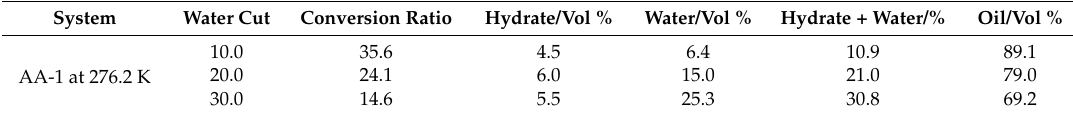
Table 3. Conversion ratios of water and volume fractions of different phases for equilibrium viscosities of hydrate slurries for AA-1 (formed at 276.2 K), AA-2 (formed at 276.2 K and at 278.2 K) and AA-3 (formed at 278.2 K) systems with an initial pressure of 6.0 MPa, stirring speed of 300 rpm for all systems and a water cut from 5% to 30% 1 .